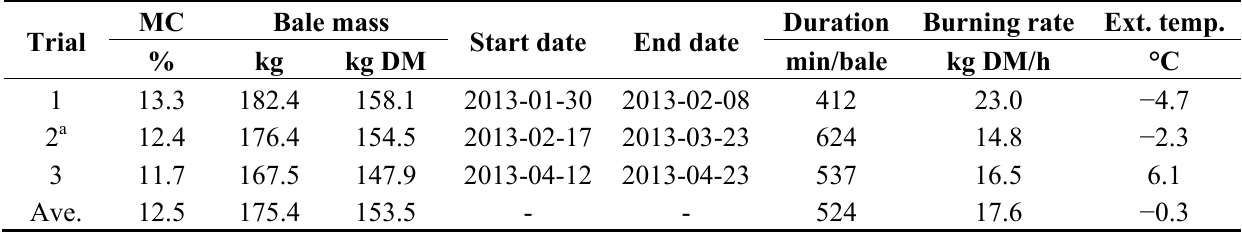
Table 6. Average data for 30-bale CS combustion validation (2013